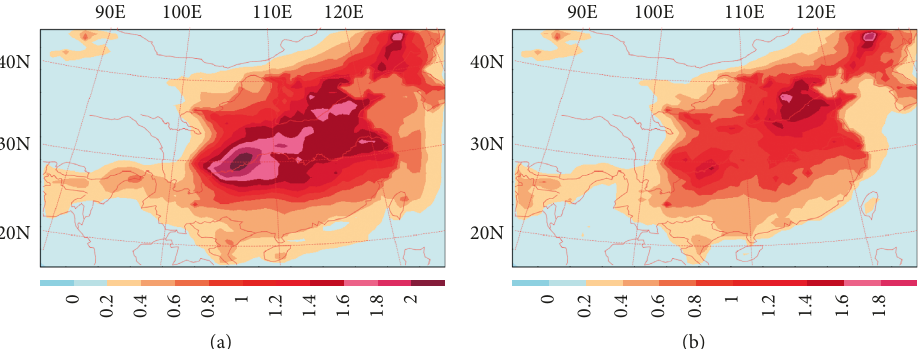
Figure 7: Top-of-atmosphere radiative forcing (TRF; W/m 2 ). (a) All-sky TRF. (b) Clear-sky